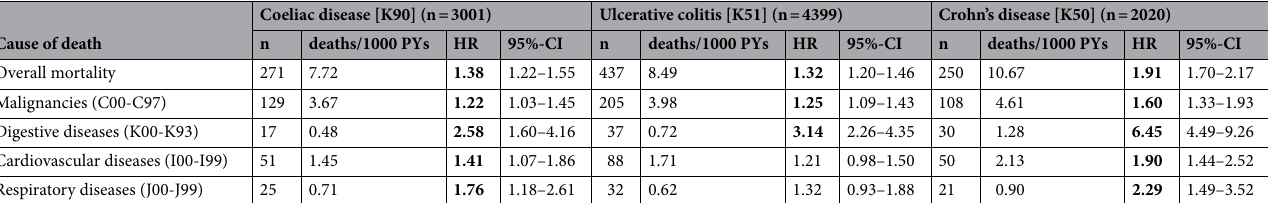
Table 2. Overall and disease-specific mortality in subjects with analysed intestinal disorders. Multivariable hazard ratios were determined for patients with coeliac disease, ulcerative colitis, and Crohn’s disease compared to the reference group that displays none of these conditions. All analyses were adjusted for age, sex and body mass index. For details, see Supplementary Table S4. PYs person-years, CI confidence interval, HR hazard ratio. Significant values are in